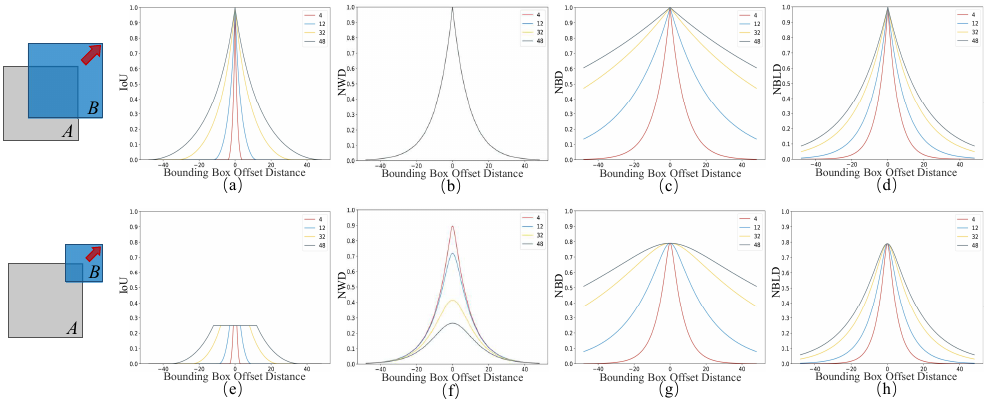
Figure 8. A comparison of ( a ) and ( e ) IoU curves, ( b ) and ( f ) NWD curves, ( c ) and ( g ) NBD curves, and ( d ) and ( h ) NBLD curves. ( a )–( d ) are with size A = size B . ( e )–( h ) are with size A = 4 × size B . The abscissa value represents the location deviation between the center points of bounding boxes A and B